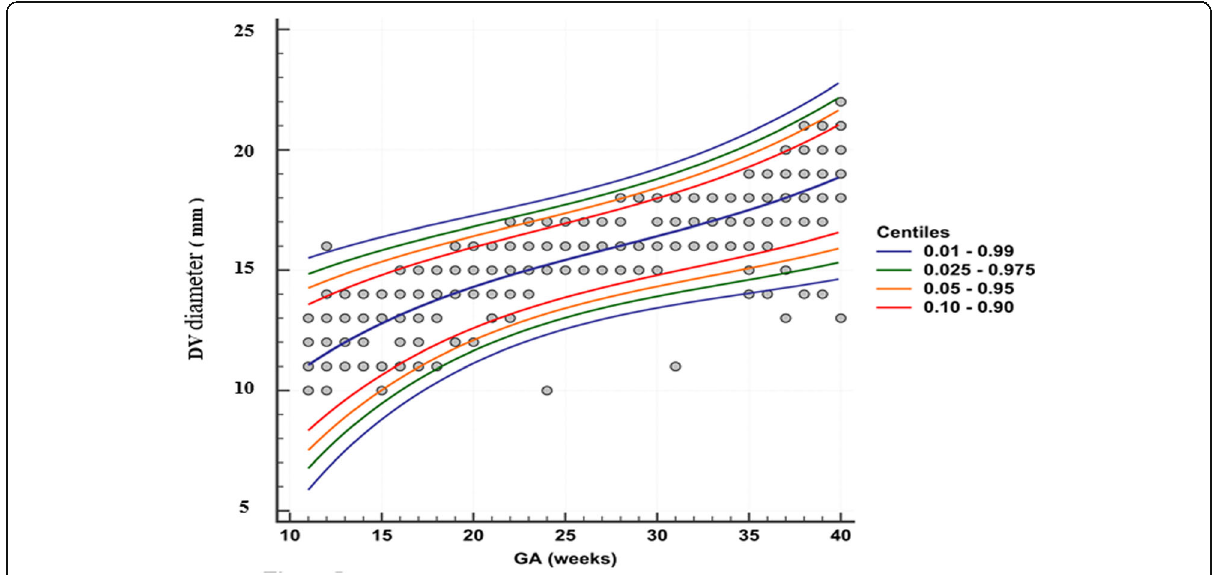
Fig. 3 Scattered diagram of gestational age individual measurement and calculated reference ranges for DV diameter in normal pregnancies based on 690 observations with 1th – 99th percentiles (blue